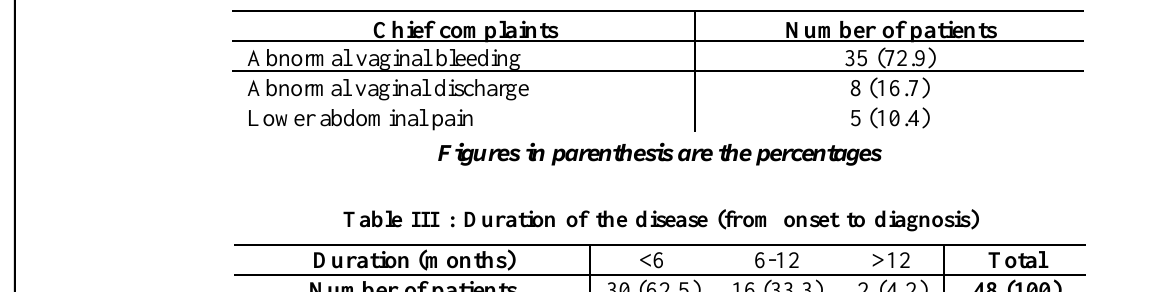
Table II : Chief complaint of the patients